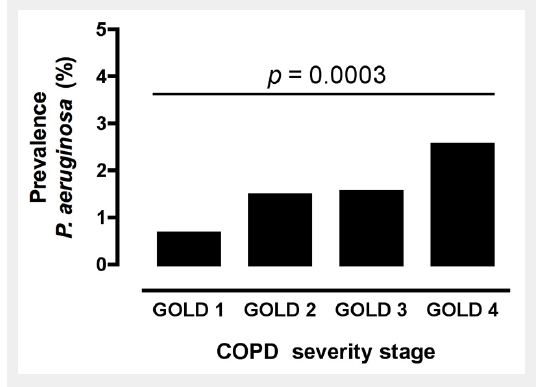
Estimated prevalences of P. aeruginosa colonisation in COPD GOLD stages 1–4. Prevalences were estimated as outlined in the Methods section and in figures 1–2. The p -value was obtained with the Chi-square test for trend comparing all GOLD stages for